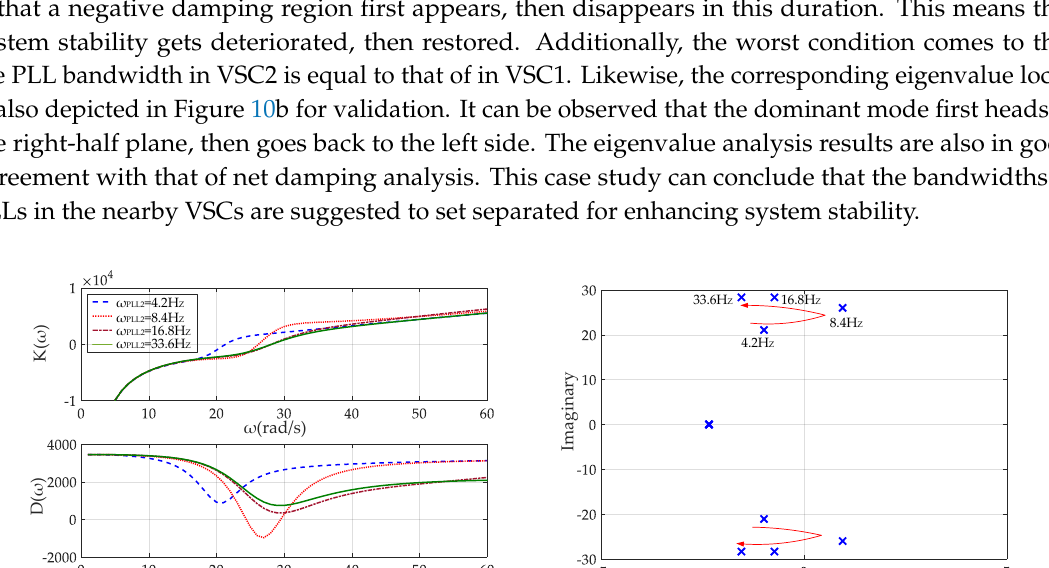
Figure 9. ( a ) Frequency response curves of spring and damping coefficients for the entire system under different bandwidths of AVC; ( b ) corresponding eigenvalue locus.